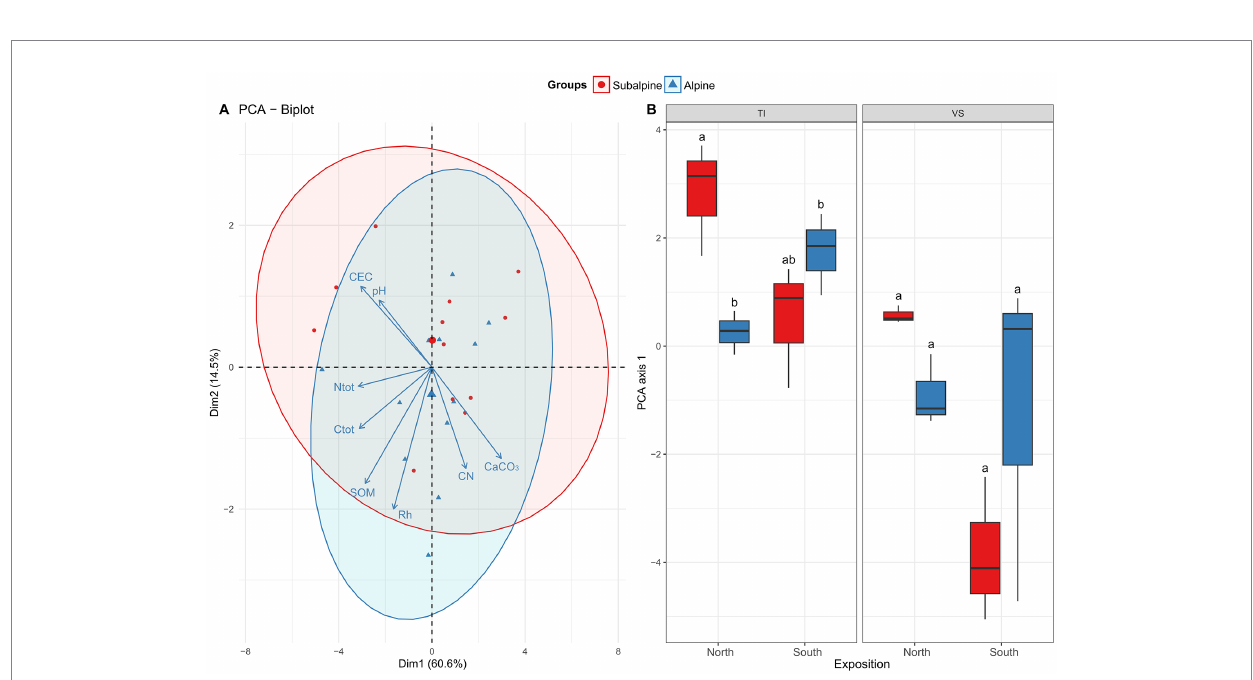
FIGURE 3 Edaphic properties. Shown is (A) the principal component analysis (PCA) biplot of eight physicochemical soil variables [pH, Cation-Exchange Capacity (CEC), total nitrogen (N tot ), total carbon (C tot ), soil OM (SOM), soil relative humidity (Rh), carbon-to-nitrogen ratio (C/N), and total carbonates (CaCO 3 )]. (B) Boxplots representing average values along the first axis of the PCA separated by exposition (North versus South facing slopes), and regions (Ticino = TI, or Valais = VS ). Letters above boxplots represent significant differences among main effects (Tuckey’s post-hoc tests; p < 0.05). Red color (warm) represents the subalpine zone (~1,400 m above sea level), and blue color (cold) represents the alpine zone (~2000 m above sea